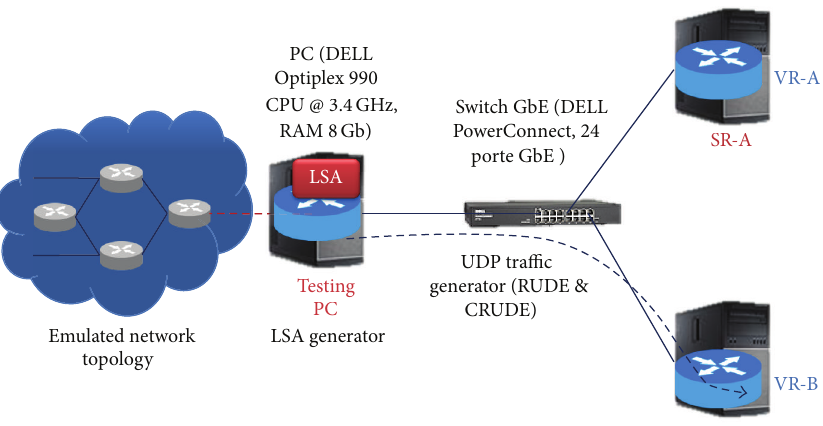
Figure 12: Test-bed for the evaluation of the migration time.